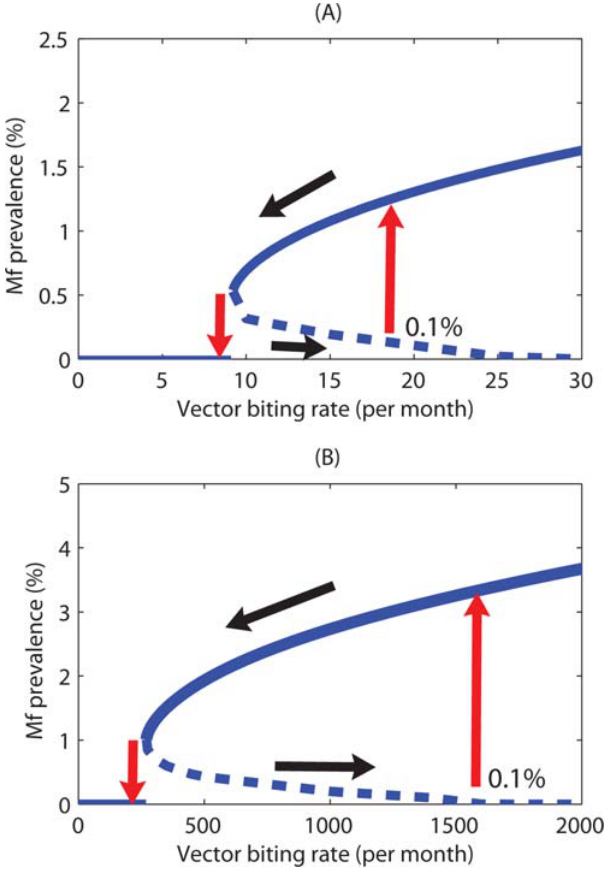
Figure 6. Hysteresis loops in the Mf prevalence/vector biting rate plane for (A) culicine and (B) anopheline intermediate hosts, showing the two asymmetrical ways by which a shift between alternative Mf stable states can occur with varying vector biting rates. If the parasite system is on the lower zero state but at high vector biting rates and thus close to the worm breakpoint bifurcation boundary, a slight incremental change in Mf levels may bring it beyond the birfurcation (say at 0.1% Mf prevalence) and induce a drastic shift of the system to its endemic equilibrium (rightmost red arrow). If one attempts to restore the parasite-free equilibrium state by reducing the vector biting rate (black leftward arrow), the system shows hysteresis. A backward shift to the parasite-free equilibrium (leftmost red arrow) will occur only if the vector biting rate is reduced far enough to reach the TBR bifurcation point. The hysteresis loop is wider in extent for the anopheline model compared to culicine-transmitted filariasis.